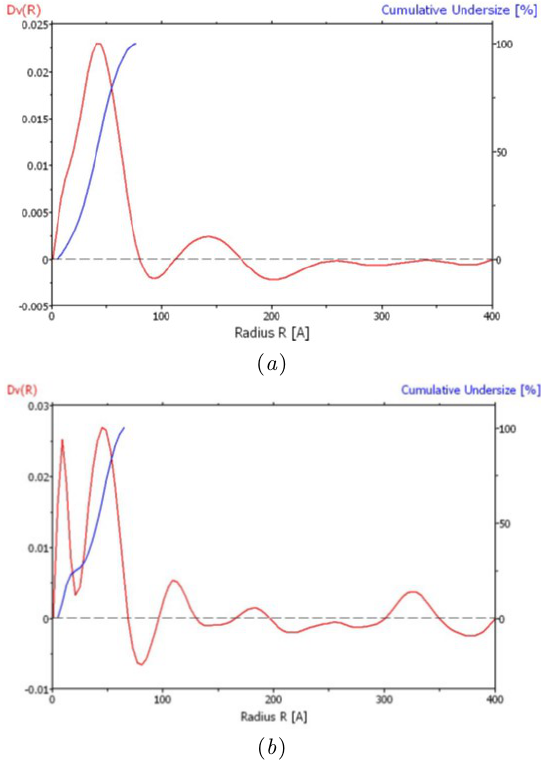
Figure 4: Size distribution by volume of ( a ) 40 µm , and ( b ) 44 µm TiO 2